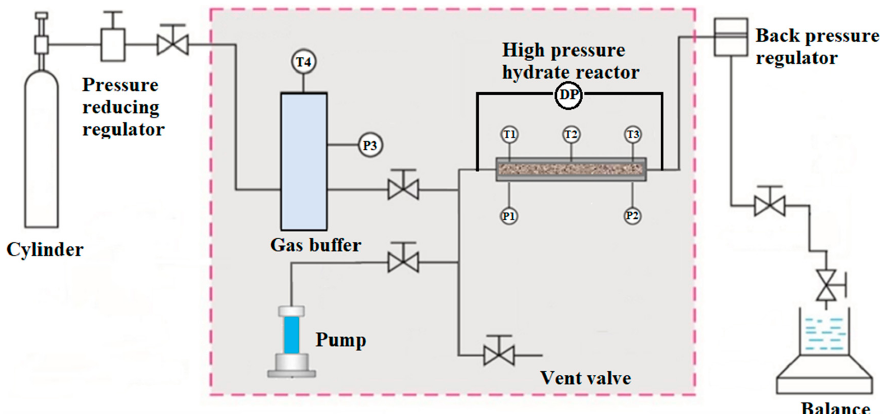
Figure 1. Schematic of experimental apparatus.